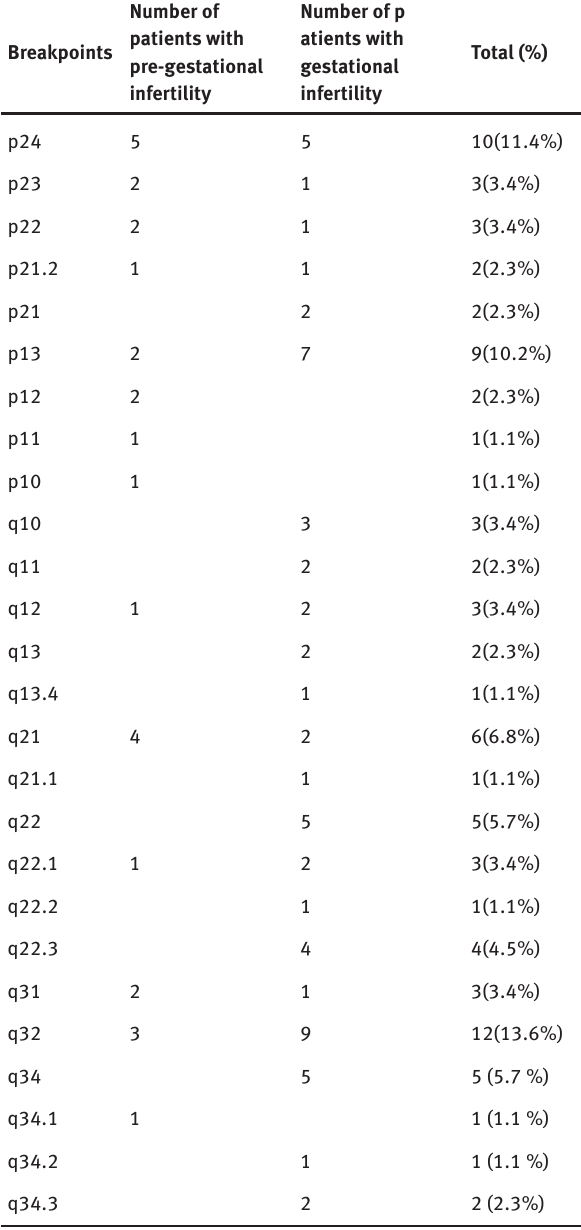
Table 3: Incidence of breakpoints on chromosome 9